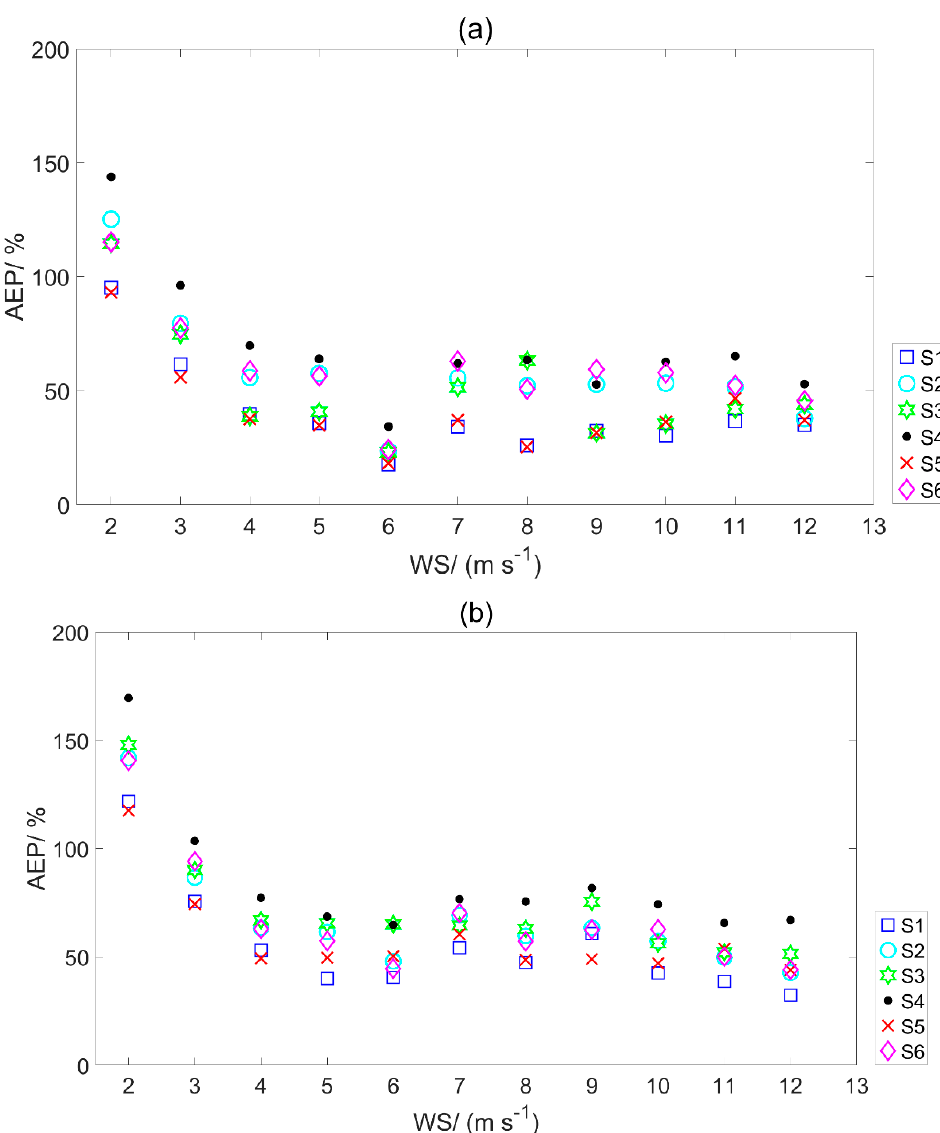
Figure 3. Absolute error percentage (AEP) distributions of WS simulation at Anxi station for different scales of WS. Simulation result with ( a ) the global forecast system (GFS), and ( b ) the ERA5.